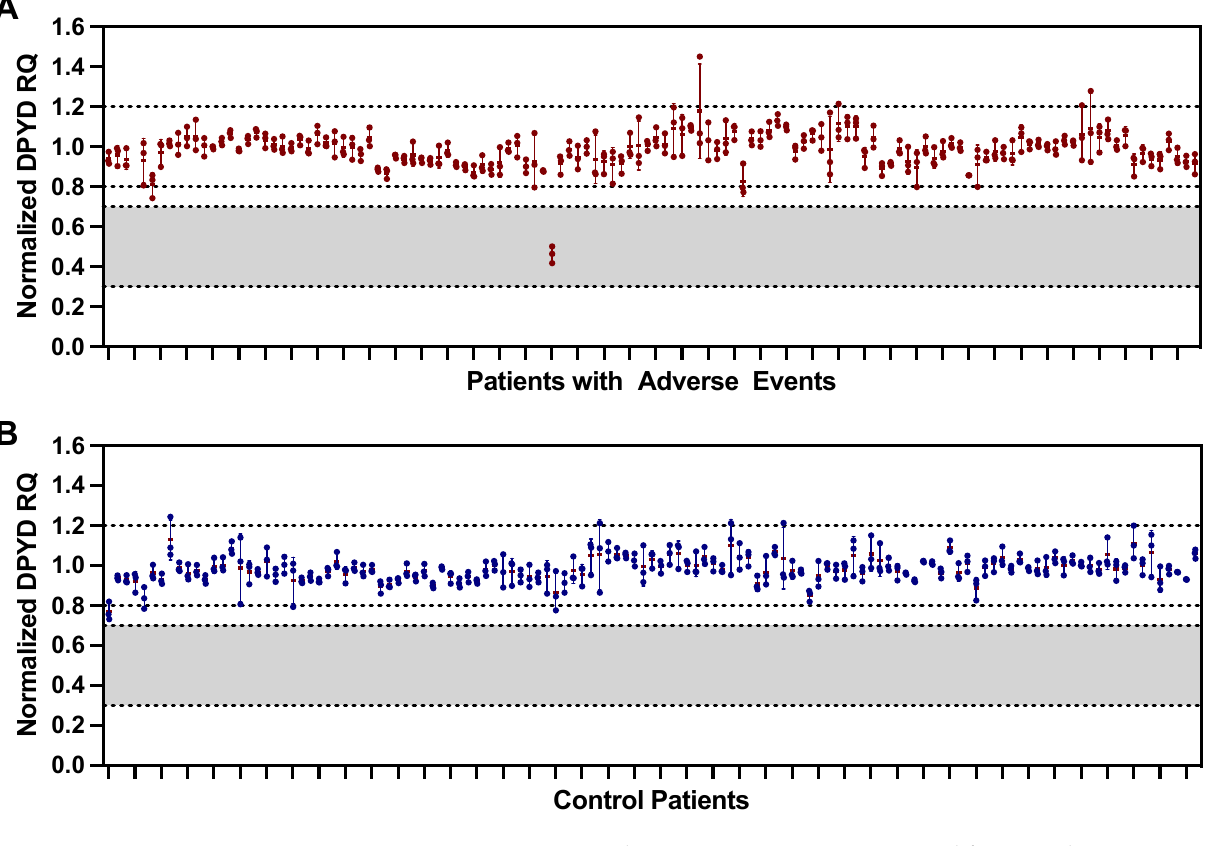
Figure 1. DPYD Exon 4 Copy Number Variation. DPYD exon 4 amplification relative to RNaseP as relative quantification (RQ) values for ( A ) adverse event and ( B ) control patients. An RQ value of 1 indicates a diploid copy number, while a ratio of 0.5 implies a haploid deletion. Points are technical replicates, bars are mean ± standard deviation. Table 3. Genomic deletions and duplications reported in DPYD resulting in phenotypic changes.